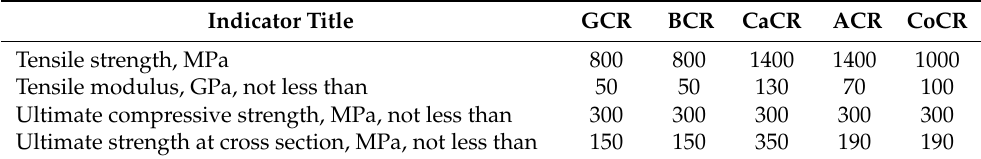
Table 7. Characteristics of the used polymer composite reinforcement.